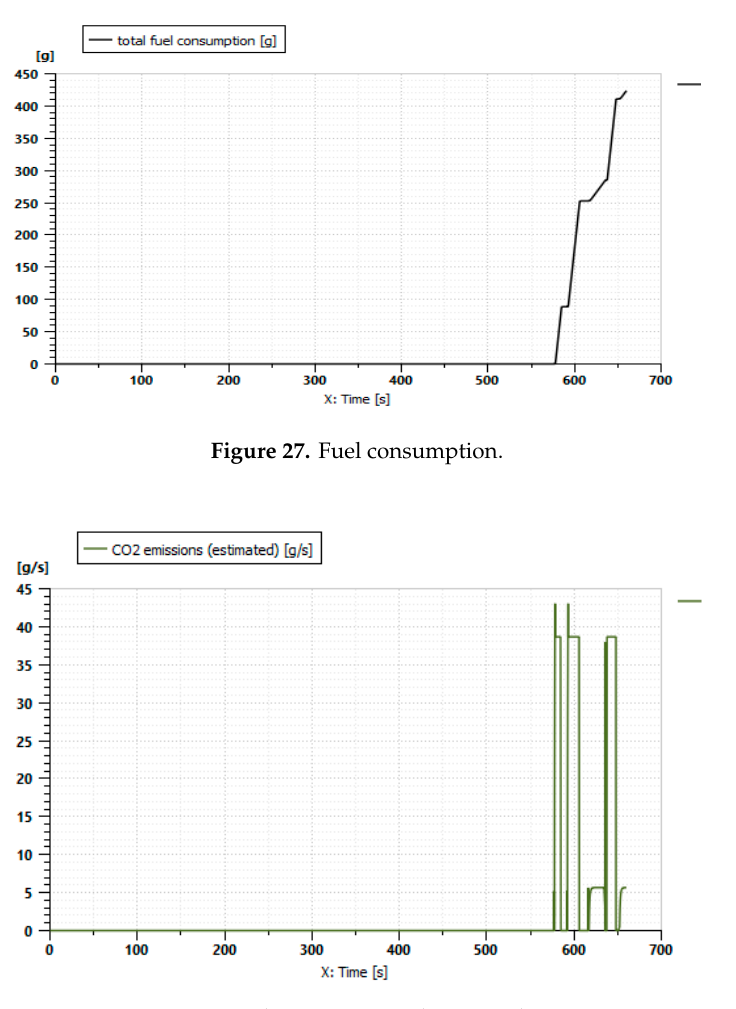
Figure 26. Battery’s state of charge. World Electric Vehicle Journal 2020 , 11 , x